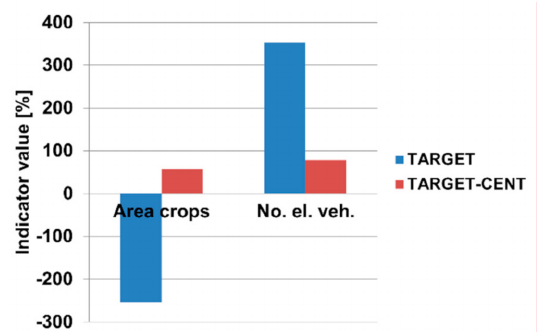
Figure 7. Example of a trade-off between two